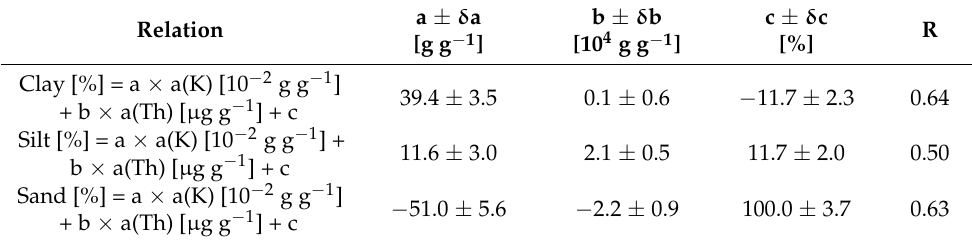
Table 3. Results of the MLR analyses between textural fractions (clay, silt and sand) and radioelement abundances (a(K) and a(Th)) performed on the training dataset (N = 578). The parameters (a, b and c) are reported together with their associated uncertainties ( δ a, δ b and δ c) ( δ a, δ b and δ c are calculated by taking the square root of the diagonal elements of σ 2 is the variance of the errors, N is the number of data, p is the number of independent variables, y the i-th observed value of the dependent variable and ˆy the matrix of the independent variables at each of the N data points) and the multiple correlation coefficient,